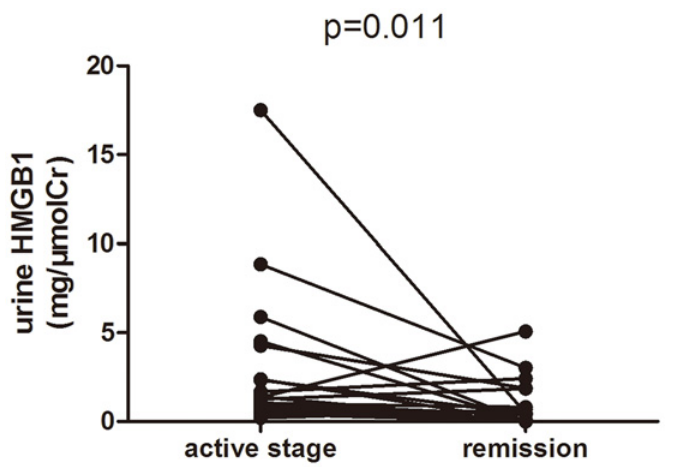
Fig 2. Changes of urinary HMGB1 levels in 19 AAV patients with sequential urinary samples.